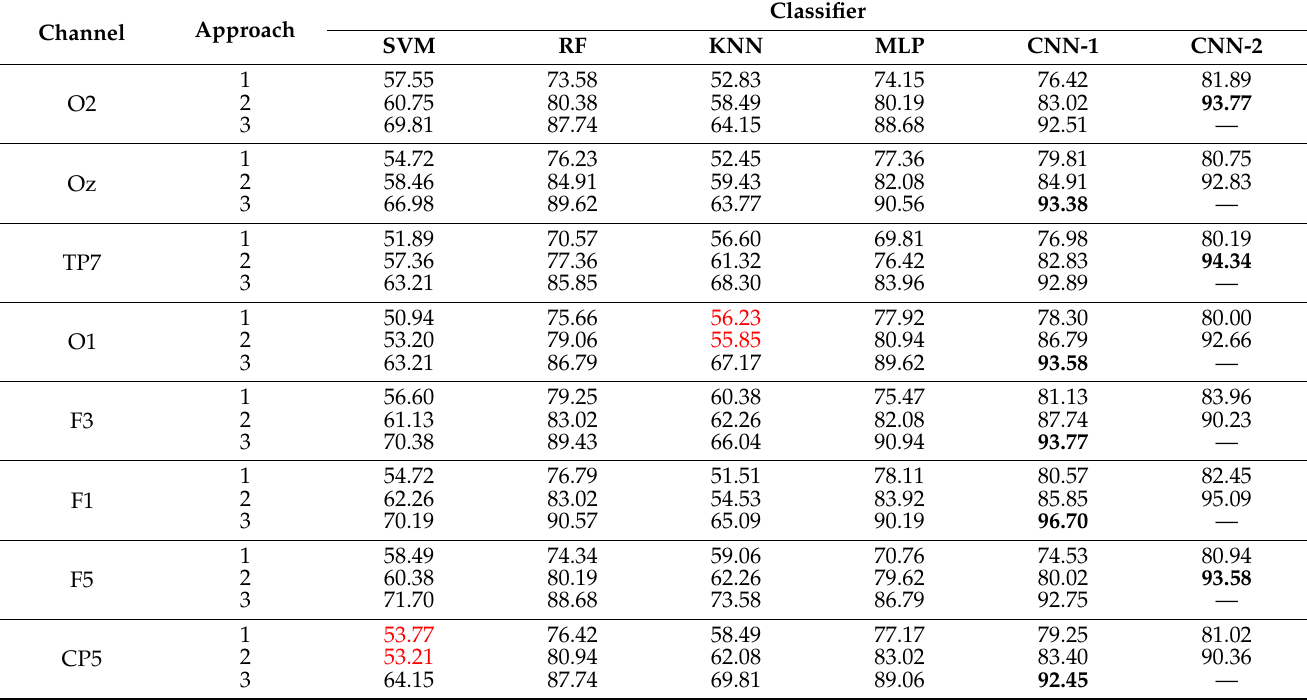
Table A4. Classification accuracies of the ERPs of Subject b 4 . Inconsistent results are highlighted in red. The best result for each channel is highlighted in bold